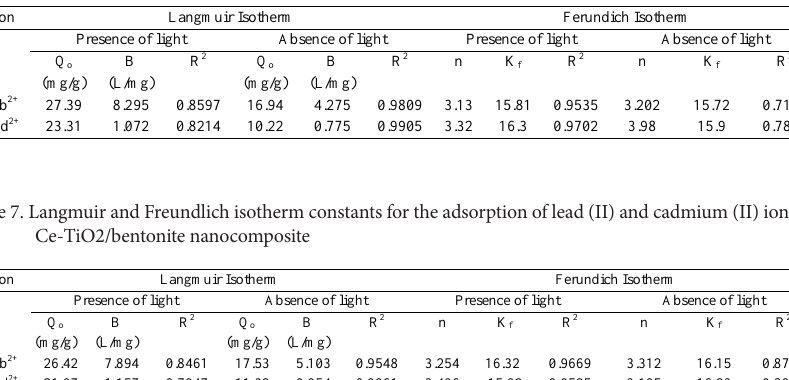
Table 6. Langmuir and Freundlich isotherm constants for the adsorption of lead (II) and cadmium (II) ion by Nd-TiO 2 / bentonite nanocomposite